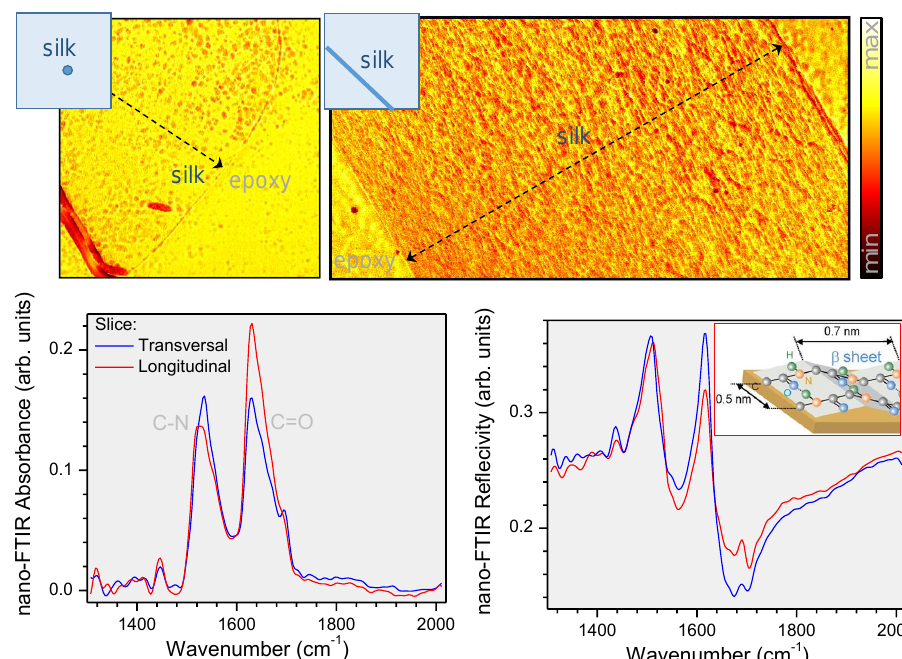
Figure 5. SNOM maps of the transverse and longitudinal silk slices together with averaged nano-FTIR absorbance and reflectance spectra. Inset in reflectivity panel shows the molecular orientation of the amide-I,II bands in β -sheet crystalline regions for the longitudinal slice (adopted form ref. [17]). Note, chemical bonding in the β -sheets plane only is shown; the C=O bonds have a radial distribution along the fiber direction and their second order momentum distribution was determined in the Supplementary of ref. [17].